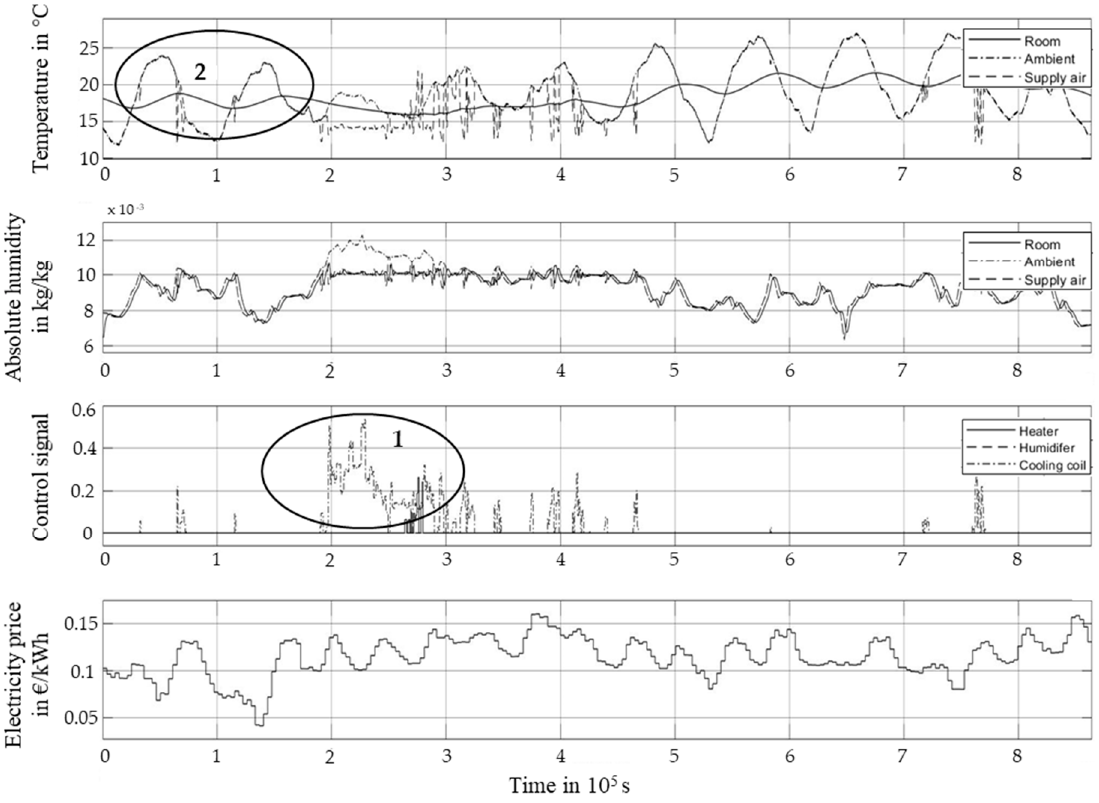
Figure 7. Cost-optimised EMPC with an electricity price with dynamic EEG allocation over ten days in summer.